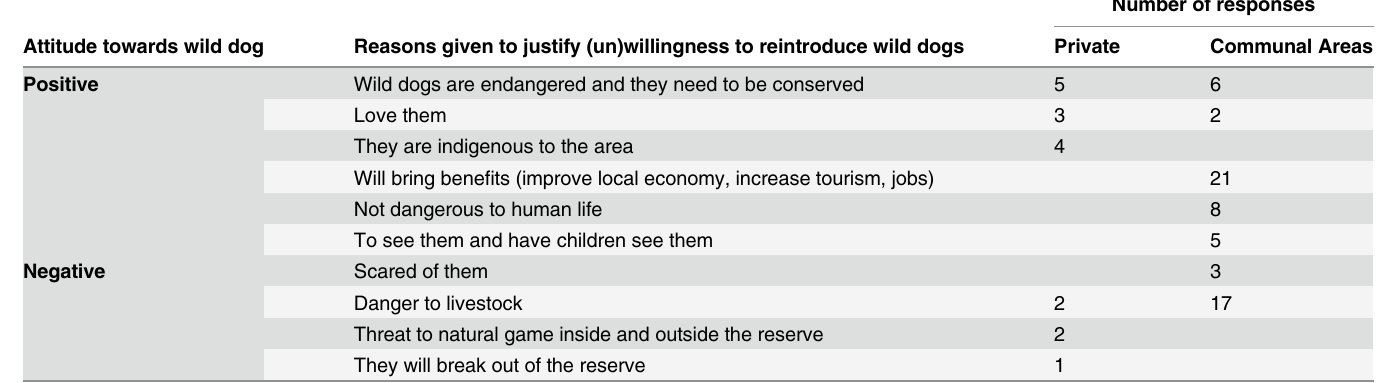
Table 1. Reasons given by respondents to justify willingness/unwillingness to reintroduce wild dogs to the Great Fish River Nature